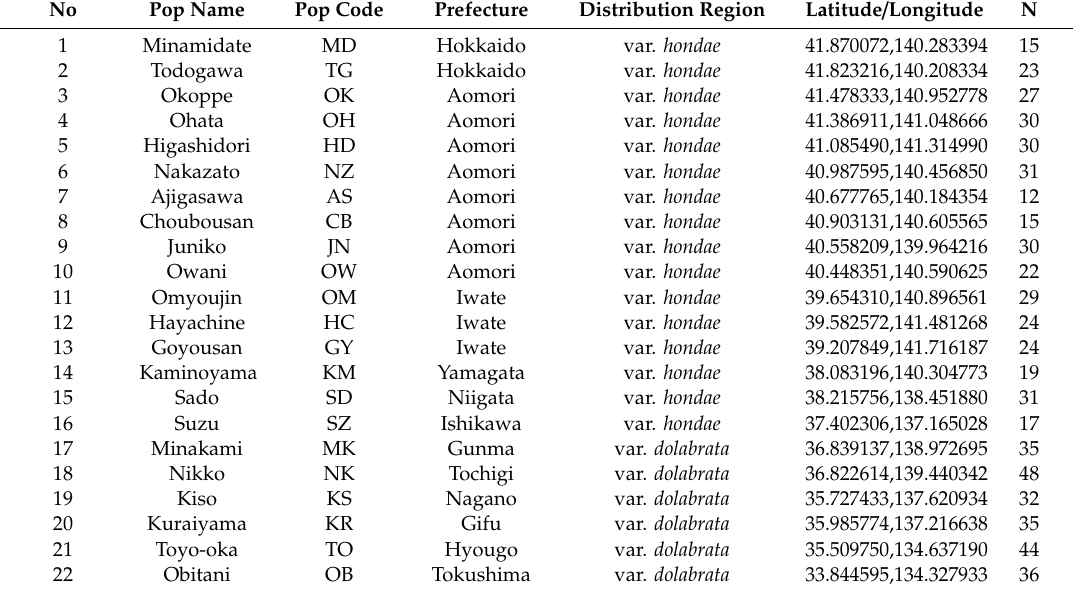
Table 1. Locations of Thujopsis dolabrata . Populations 1 to 16 fall within the range of var. hondae and 17 to 22 fall within var. dolabrata